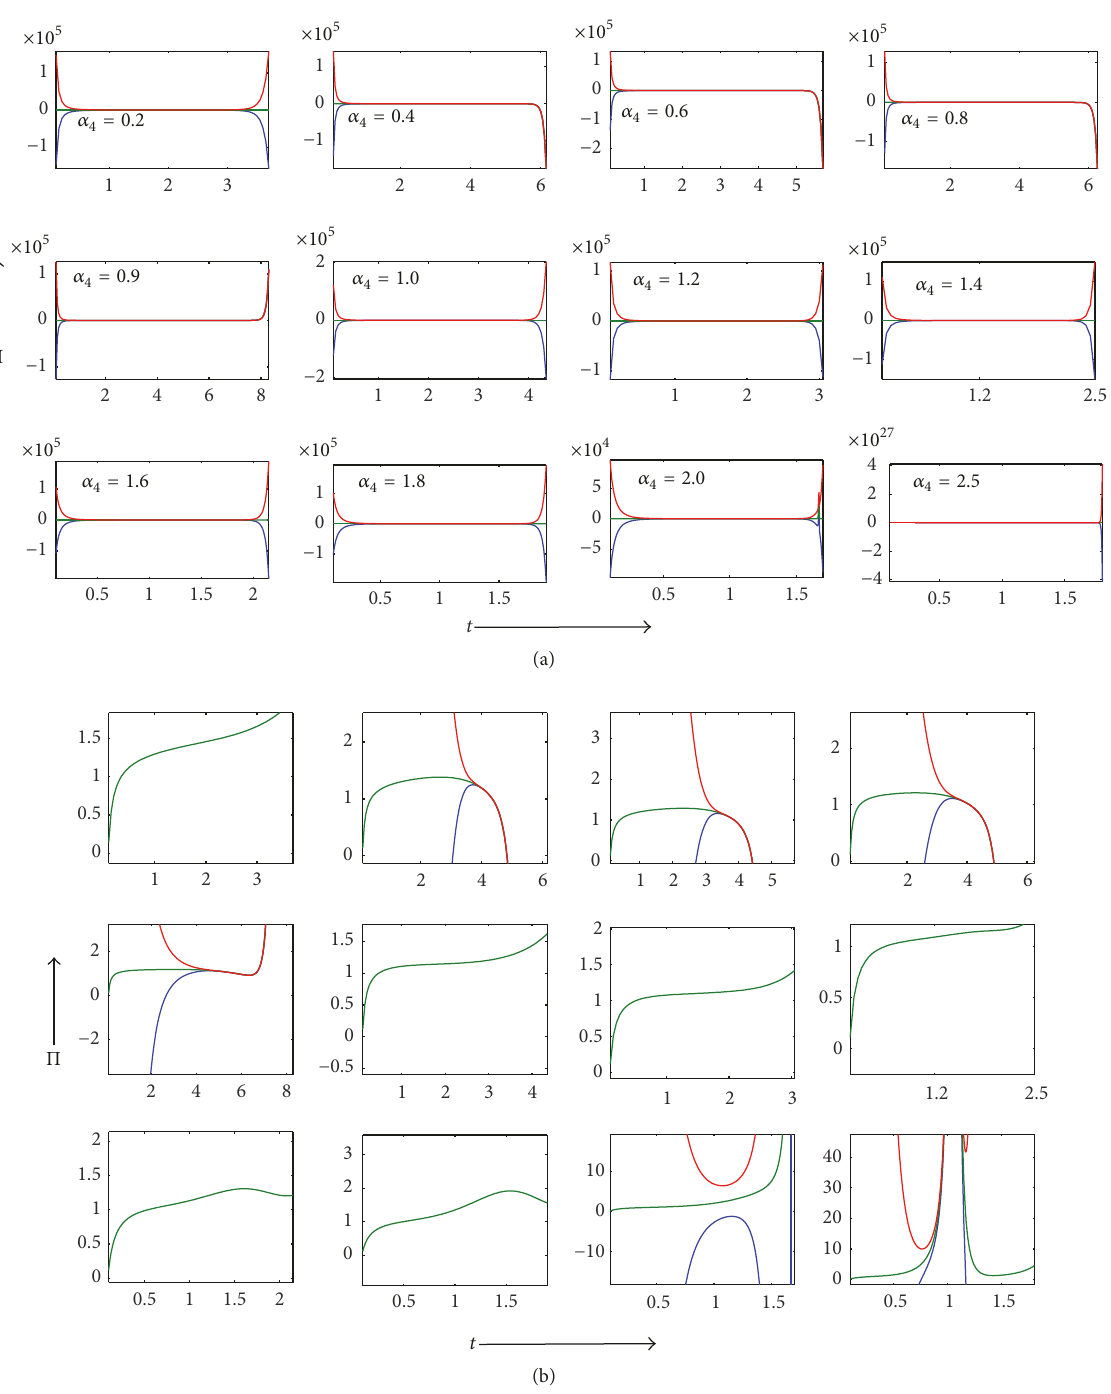
Figure 16: Variation of bulk viscous stress Π against time for 𝛼 1 = 0.5 , 𝛼 5 = 0.3 , 𝐴 = 𝐵 = 1 , 𝑛 = 0.1 , 𝜔 = 1 , 𝜙 0 = 1 , 𝑐 2 = 0.1 , and different 𝛼 4 . (b) shows the zooming of (a). Blue line, Green line, and Red line represent 𝑘 = −1 , 𝑘 = 0 , and 𝑘 = 1 ,